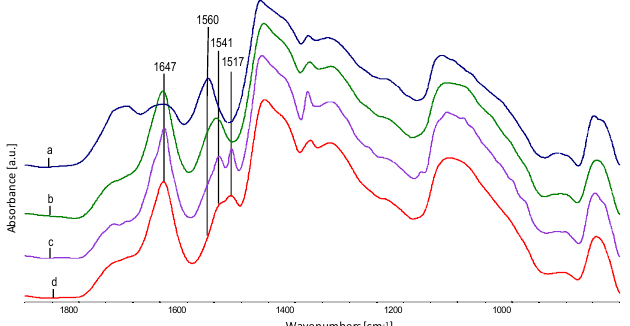
Figure 11. FTIR spectra within a range of 1900–800 cm − 1 of fibre spectra, after extraction in water and AgNO 3 saturated A-series fibres and reduced to AgNPs: ( a ) spectrum for A0.0; ( b ) spectrum for A0.2; ( c ) spectrum for A1.0; ( d ) spectrum for A5.0.